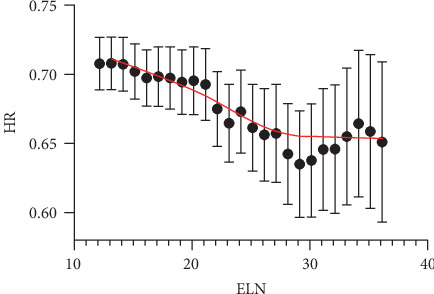
Fitting curves of ELN number HR of tumor-specific death in node-negative CRC.